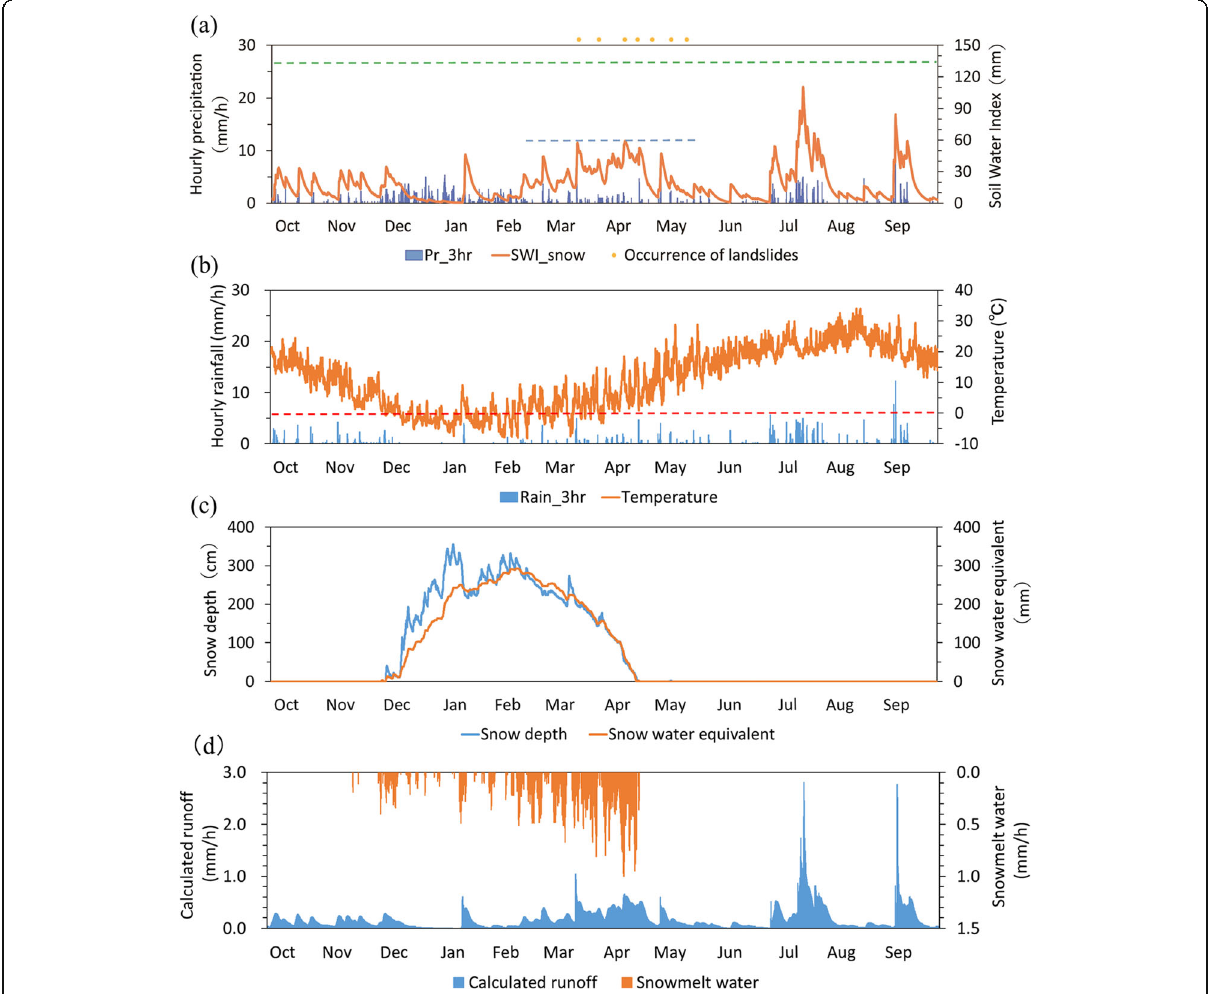
Fig. 5 a Same as Fig. 4b but modified SWI with considering snowfall-accumulation-snowmelt processes. The maximum SWI for March – May (57 mm) of the past 10 years (1995 – 2004) is also plotted as blue dashed line. b Average of three-hourly rainfall and temperature at AMeDAS Sekiyama. The red dashed line represents 0 °C. c Observed snow depth (blue line) and calculated snow water equivalent (orange line) from October 1, 2005, to September 30, 2006, at AMeDAS Sekiyama. d Calculated runoff (blue bar) and snowmelt water (orange bar) from October 1, 2005 to September 30, 2006 at AMeDAS Sekiyama. Note that the right axis is